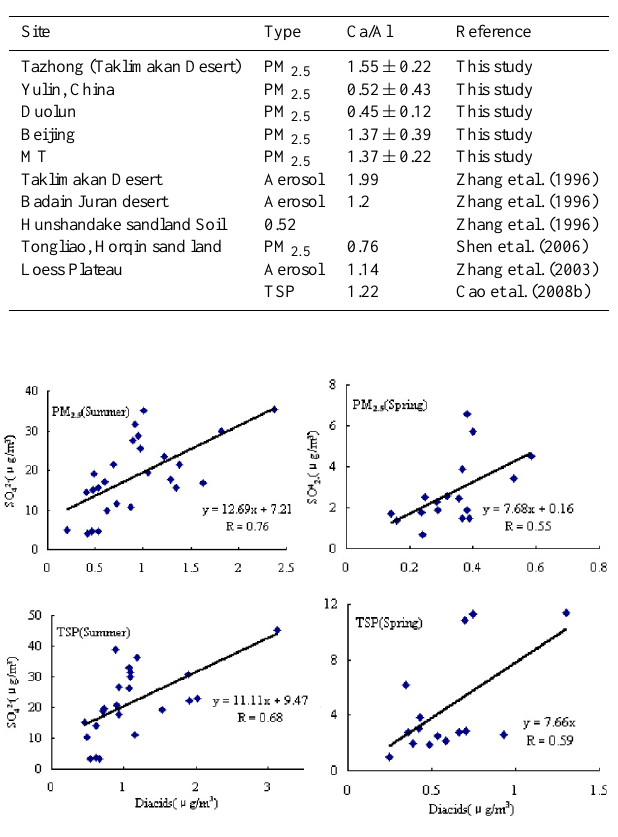
vs. decides (sum of CH 2 C 2 O 2 − 4 ). 4